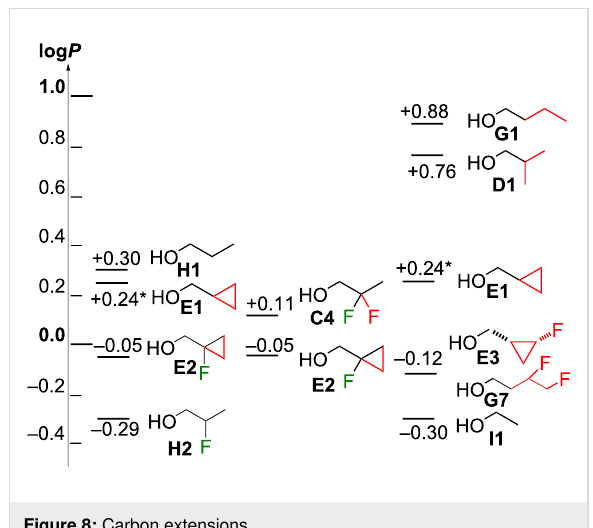
Figure 8: Carbon